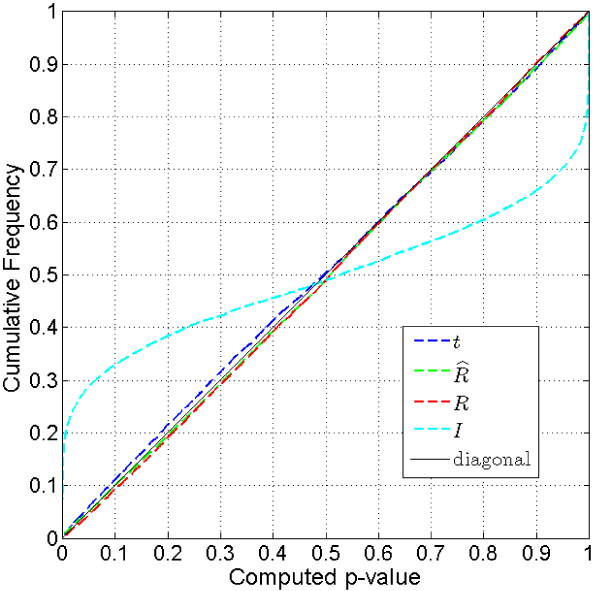
Cumulative distribution of p-values for one-sided test case with sample size n = 15. The corrections become better with a larger sample size. All of the correction methods give right adjustment as the prediction of the correlation becomes fairly accurate.